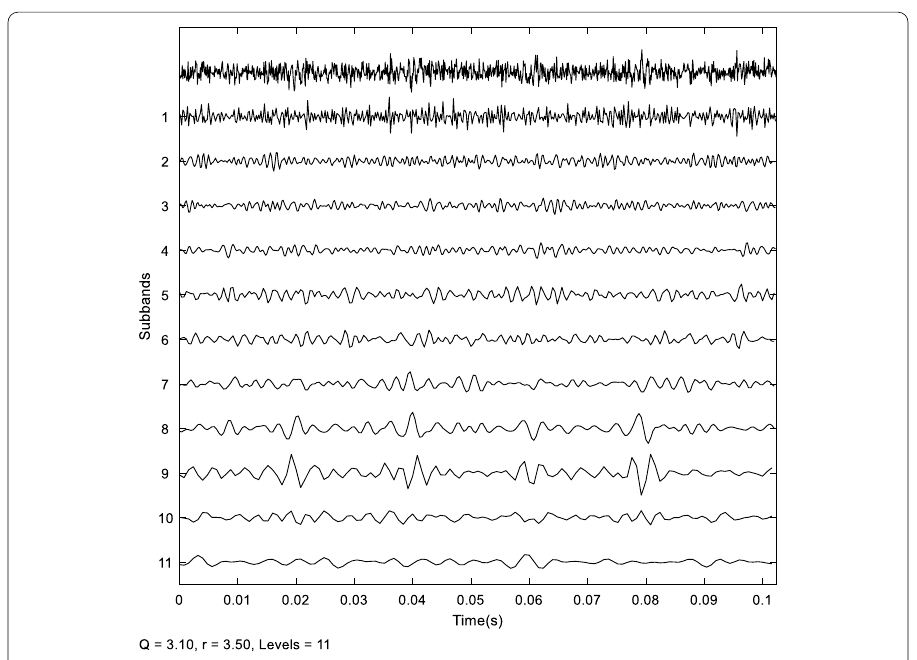
Fig. 4. 11 layers TQWT decomposition. The simulation signal is decomposed into 11 layers according to the optimal parameter Q 3.1 and r = =